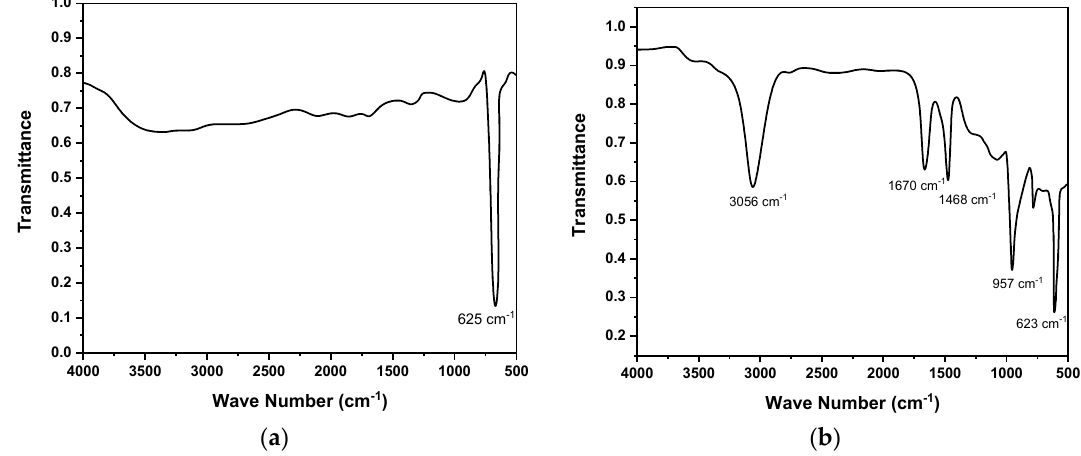
Figure 4. FTIR spectra of ( a ) Cu 2 O nanoparticles and ( b ) F8-Cu 2 O nanocomposite. Table 1. Bond dynamics in Cu 2 O and F8-Cu 2 O thin